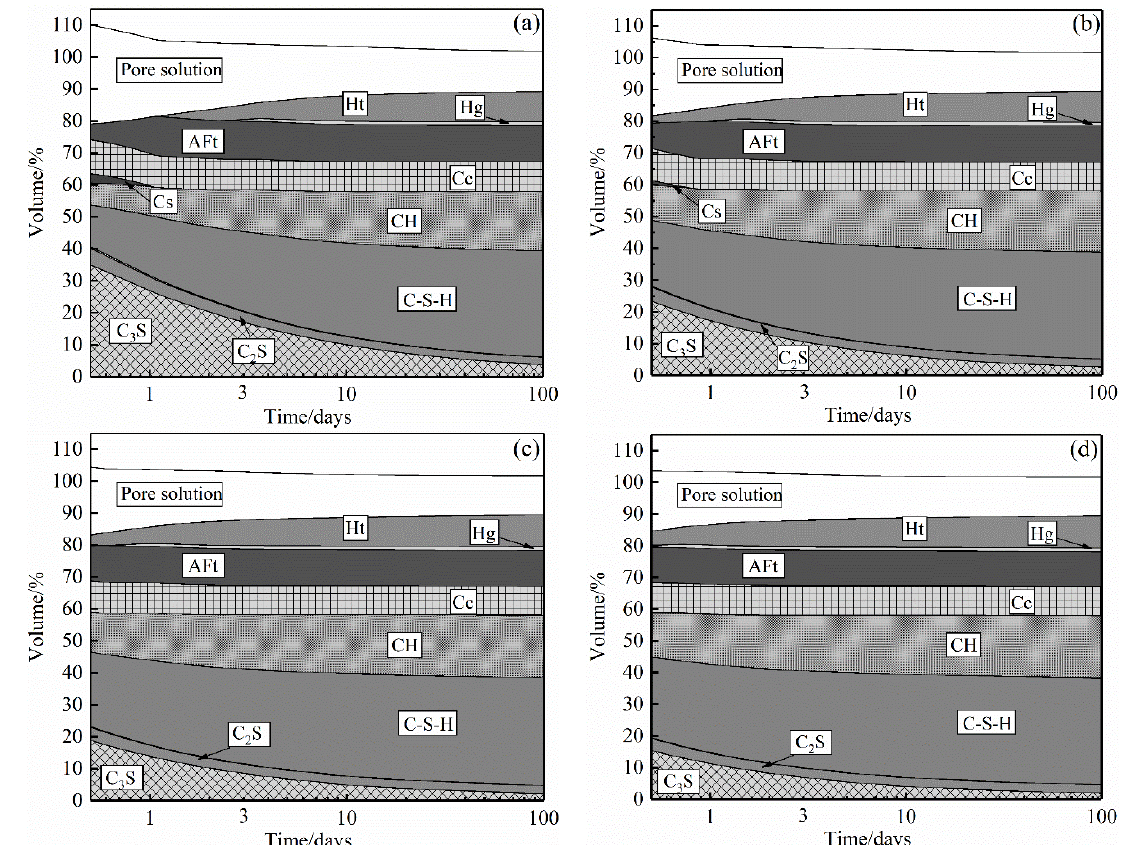
Figure 6. Relationship between hydration products and time: ( a ) 20 °C; ( b ) 40 °C; ( c ) 50 °C; ( d ) 60 °C. C 3 S, Tricalcium Silicate; C 2 S, Dicalcium Silicate; C-S-H, Calcium Silicate Hydrate; CH, Calcium Hydroxide; Cs, Gypsum; Cc, Calcite; AFt, Ettringite; Ht, Hydrotalcite; Hg, Hydrogarnet.